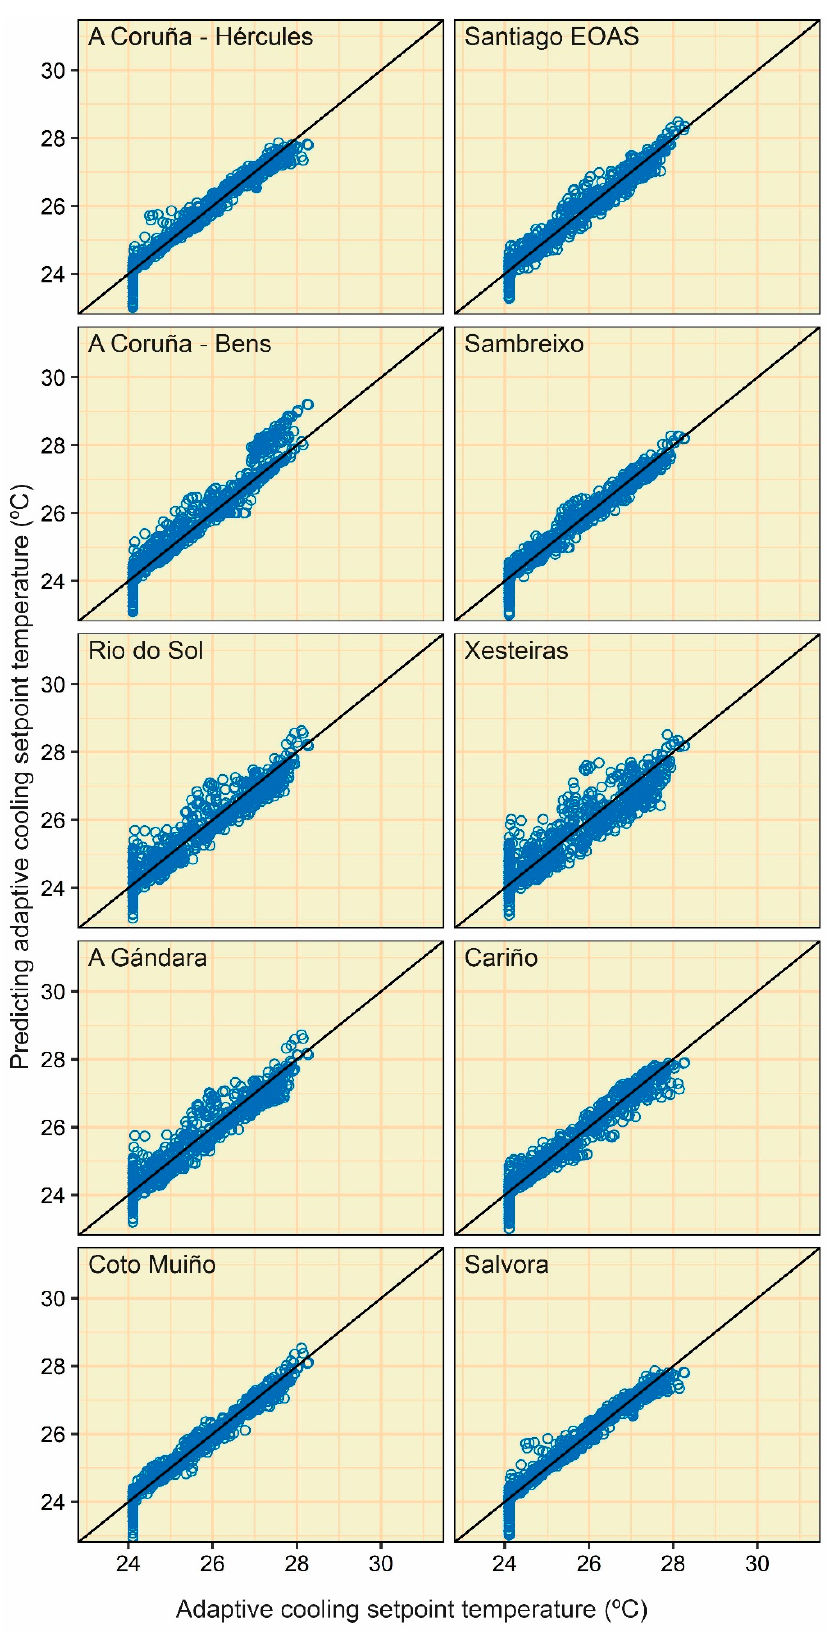
Figure A7. Point clouds between the actual and predicting adaptive cooling setpoint temperature values (category I) of the MLR (approach 2).